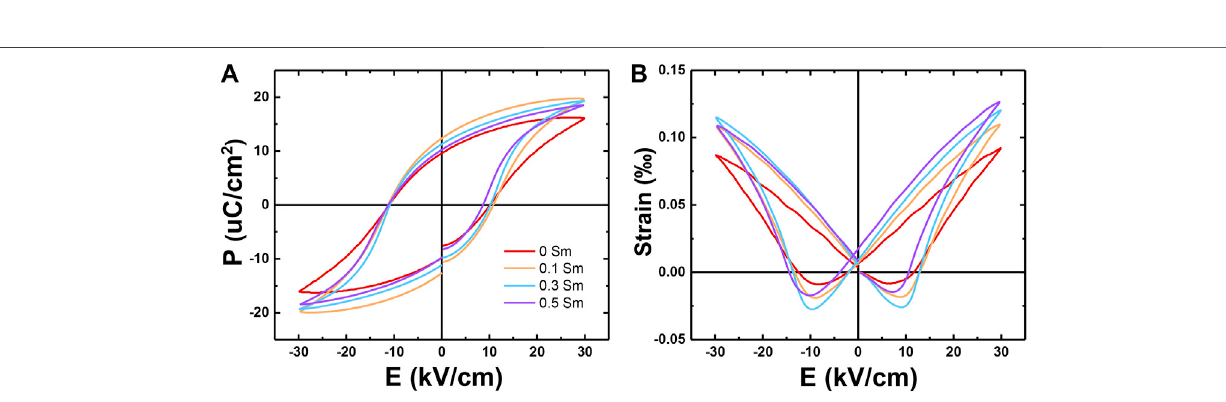
Frontiers in Materials |